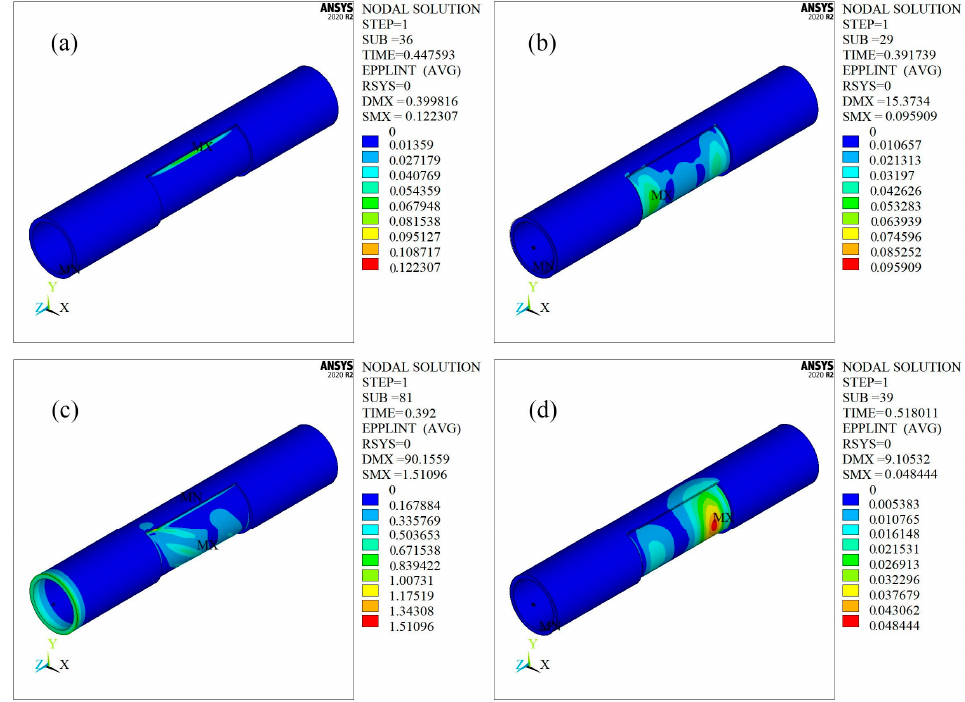
Figure 4. The plastic strain contours of a straight pipe with a local wall-thinning defect under single loads: ( a ) internal pressure; ( b ) bending moment; ( c ) torque; ( d ) axial force. The load and plastic strain at the point of maximum plastic strain in the time history were obtained. Figure 5 shows the load vs. plastic strain curves of SP LWT under different single loads at such points. The load corresponding to the last convergence point of the numerical calculation in the figure was taken as the limit load. The results of the analysis of the limit load of SP LWT under different single loads are listed in Table 6.